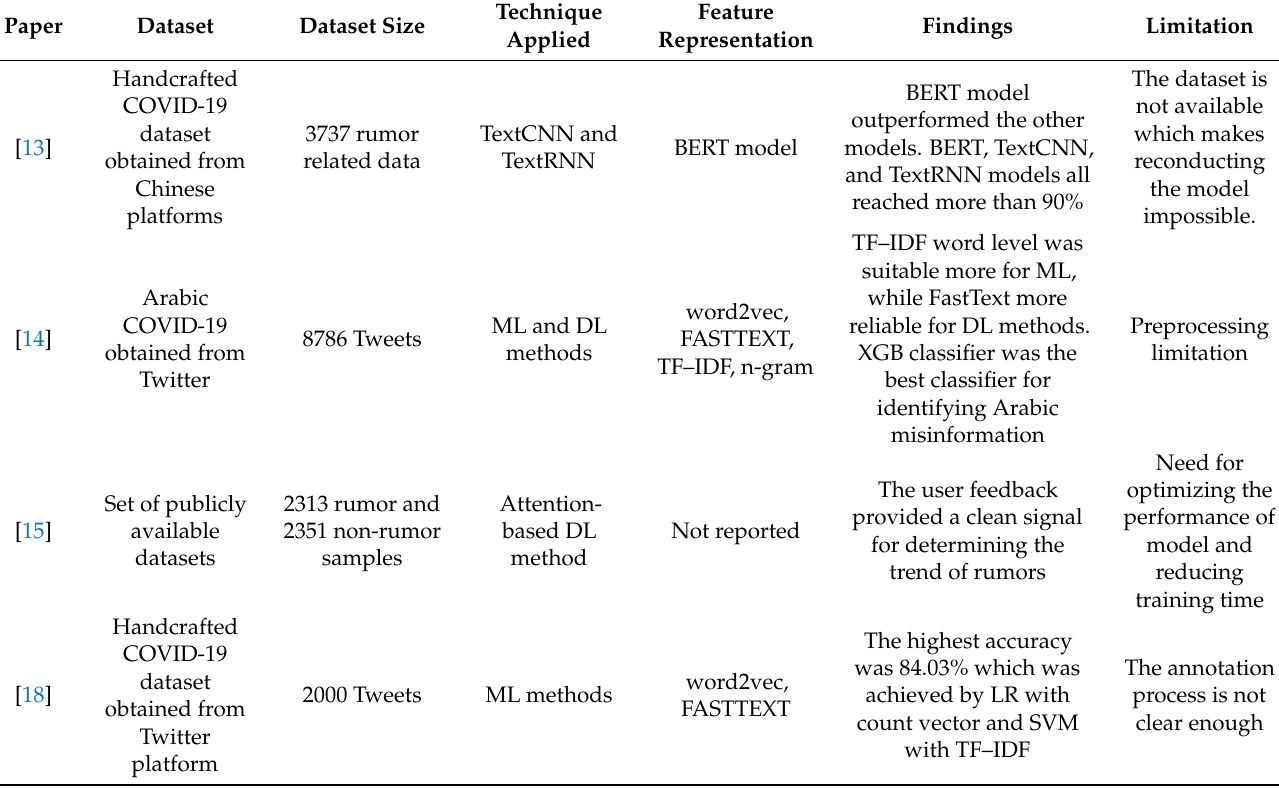
Table 1. Summary of Existing COVID-19 Detection